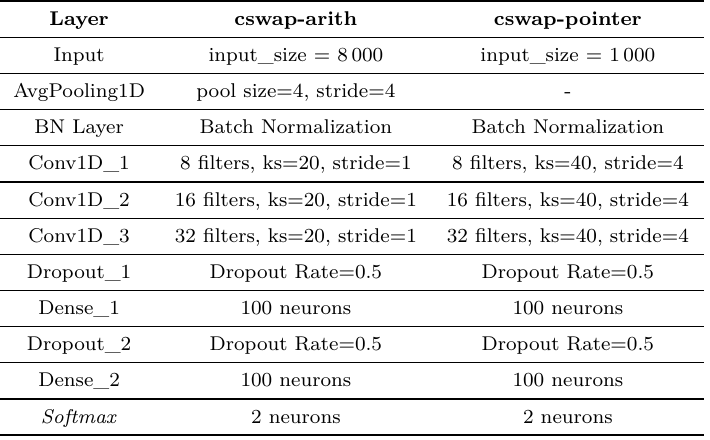
Table 3: CNN architectures without dropout layers for the two datasets described in Section